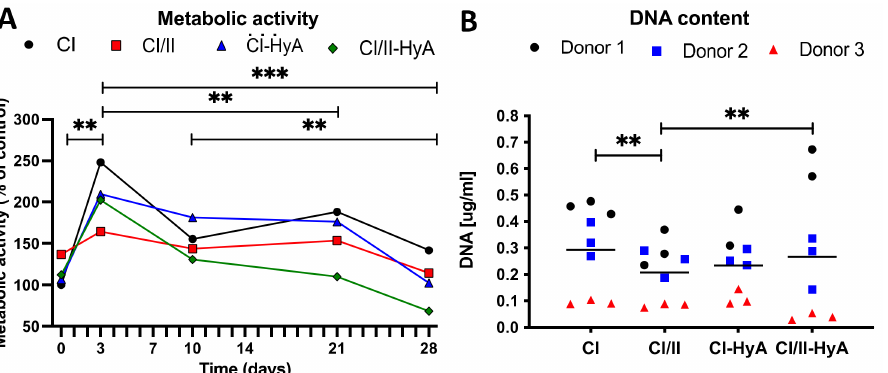
Figure 2. All collagen scaffolds supported human MSC viability up to 28 days in culture. Cellular metabolic activity per scaffold was determined and normalised to CI scaffolds at time 0 after 0, 3, 10, 14, 21 and 28 days in culture ( A ). The DNA content per scaffold was determined after 28 days in culture ( B ). Data shown represent the grand mean from three individual human MSC donors n = 3 (unless indicated differently). ** denotes p ≤ 0.01 and *** = p ≤